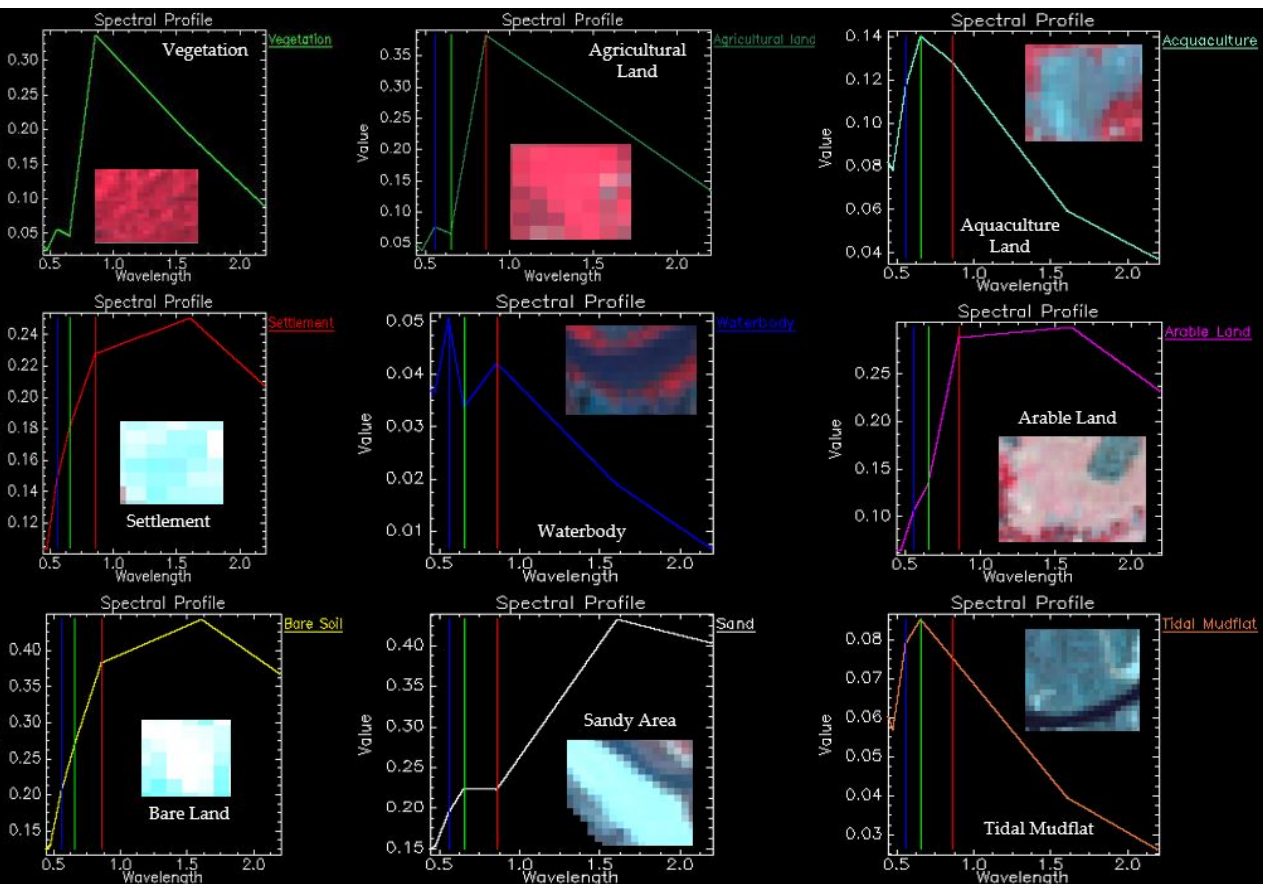
Figure 4. Selected training features spectral reflectance wavelength. Each color represents the mean reflectance wavelength value of different land cover classes. In here, light green = vegetation, dark green = agricultural land, cyan = aquaculture land, red = settlement, blue = waterbody, pink = arable land, yellow = bare land, white = sandy area, and coral = tidal mudflat (based on [30]).